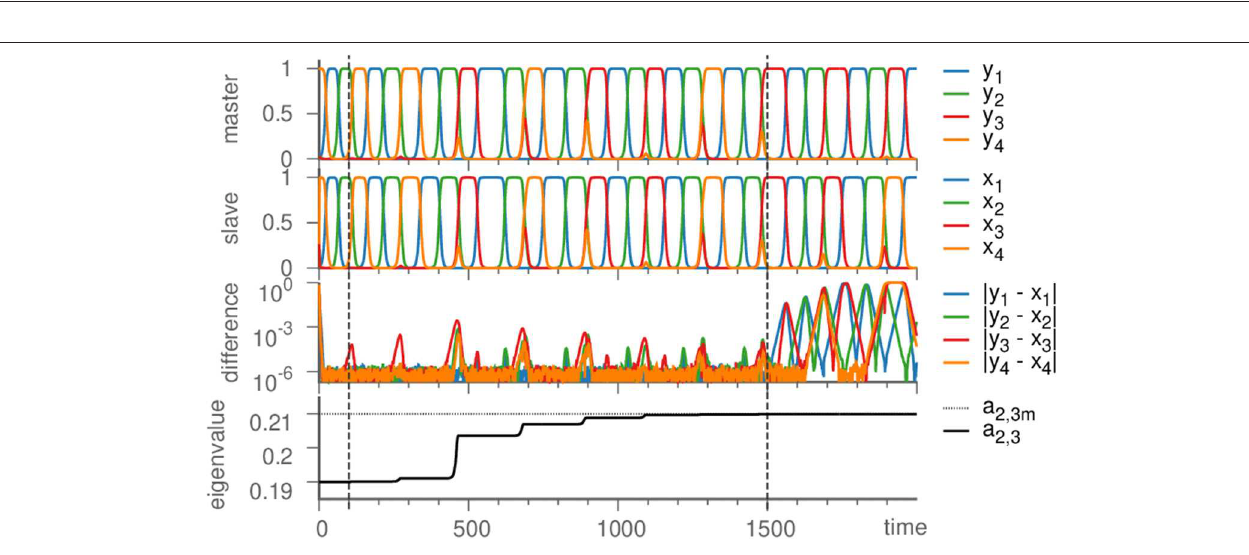
100) and its end ( t 1,500), at which time also the coupling is = = 1, γ 0.5, ζ 50, σ 10 − 6 ; eigenvalues are = = = =